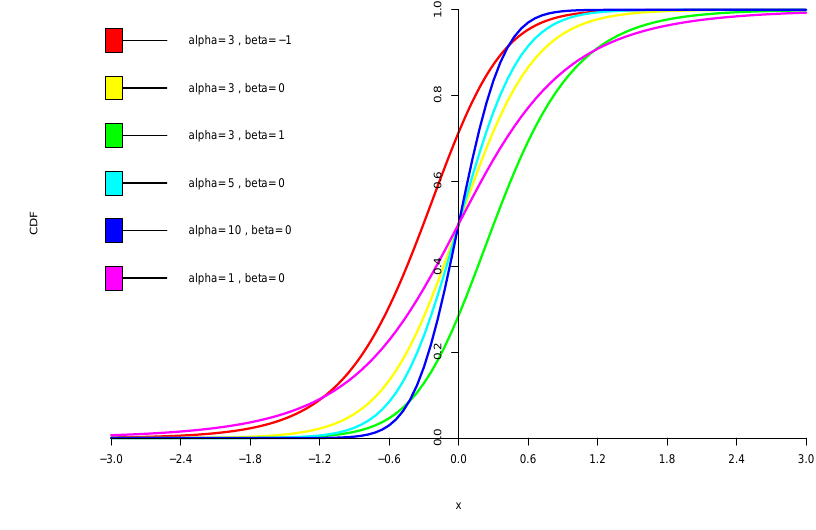
Figure 3. CDF of normal-inverse Gaussian distribution against α and β